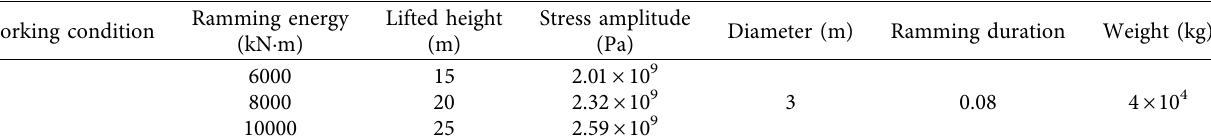
Table 1: Mechanical parameters of dynamic